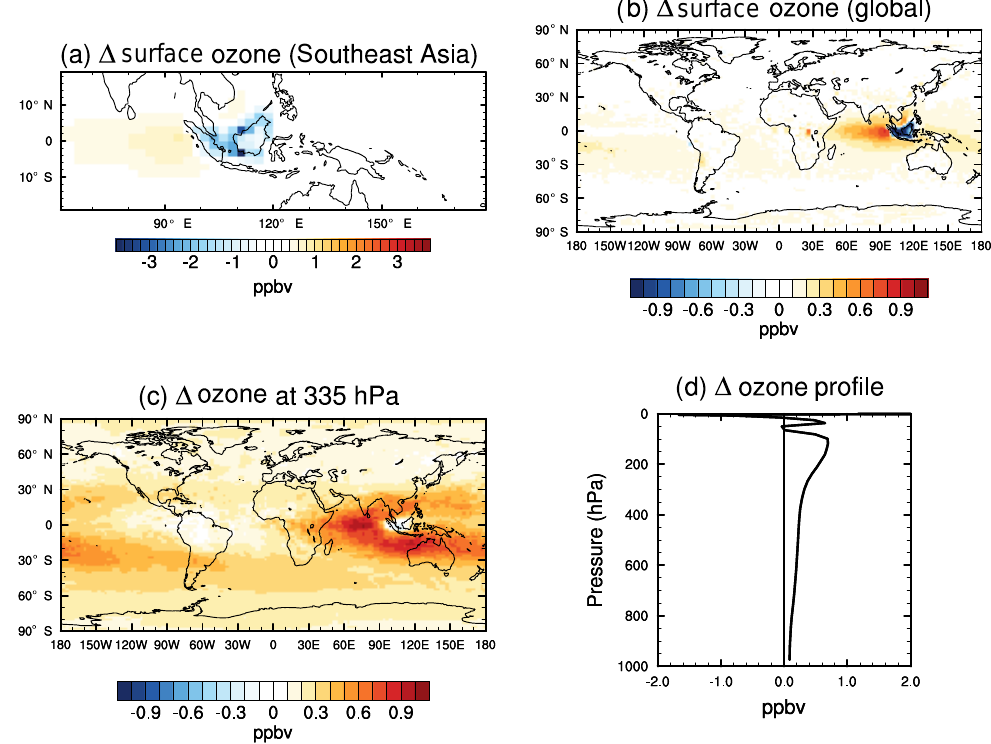
Figure 1. Changes in annual-mean ozone mixing ratio (ppbv) due to 1990–2010 maritime Southeast Asian land cover change: (a) Southeast Asian surface-level ozone; (b) global surface-level ozone; (c) tropospheric ozone at 335hPa; and (d) global-mean ozone